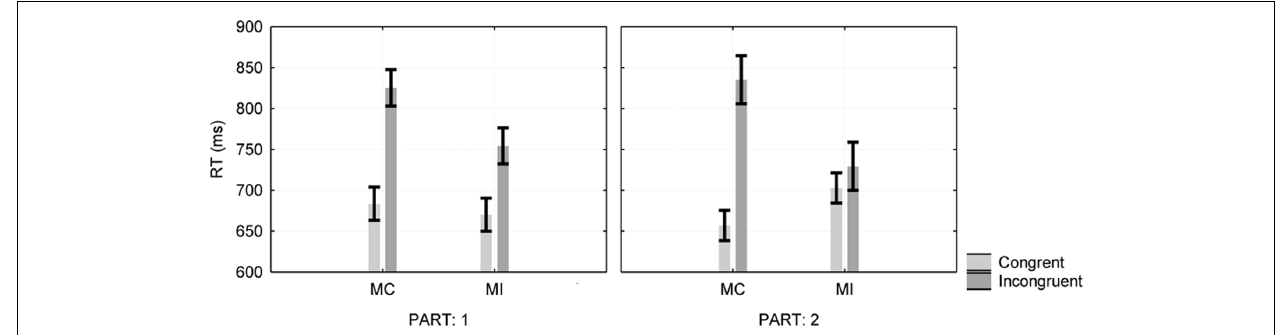
FIGURE 1 | Proportion congruent effect as a function of instruction type and experimental part in Experiment 1. Error bars are one standard error of the mean. MC, mostly congruent; MI, mostly incongruent.